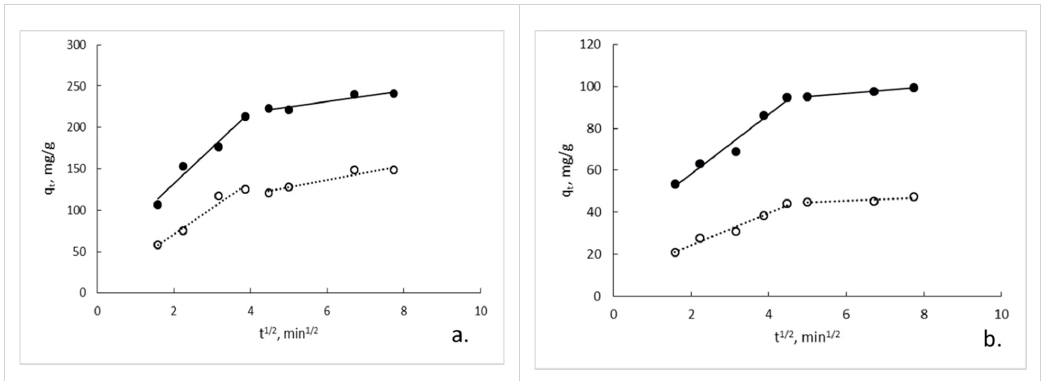
Figure 10. Intraparticle diffusion model for Zn (II) sorption from aqueous solutions under